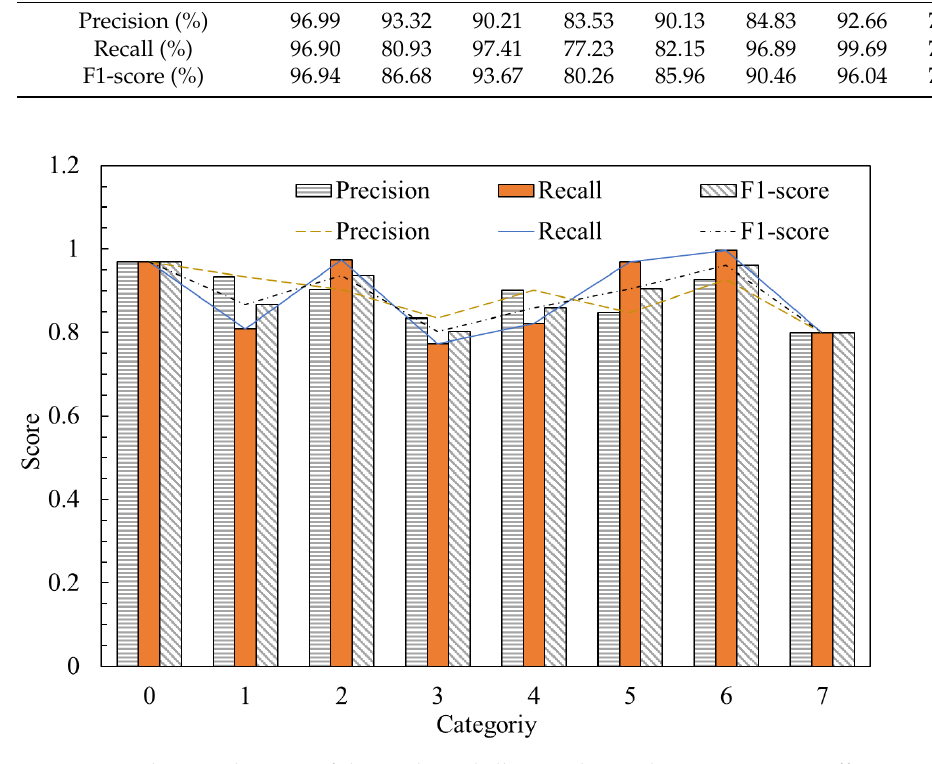
Figure 3. Evaluation diagram of the stacking drilling multi-condition recognition effect.